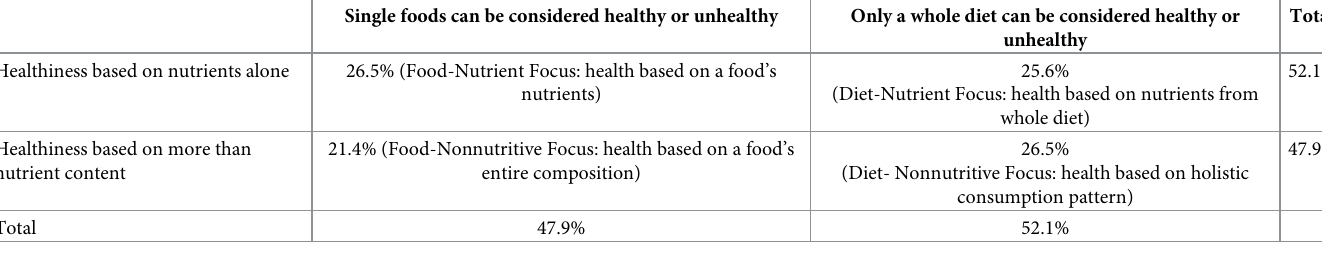
Note: sampling error for each statistic is ± 2.7%.